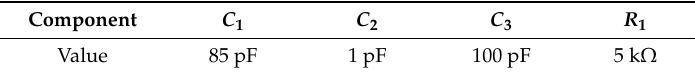
Figure 6. Schematic diagram of the PD measurement system.